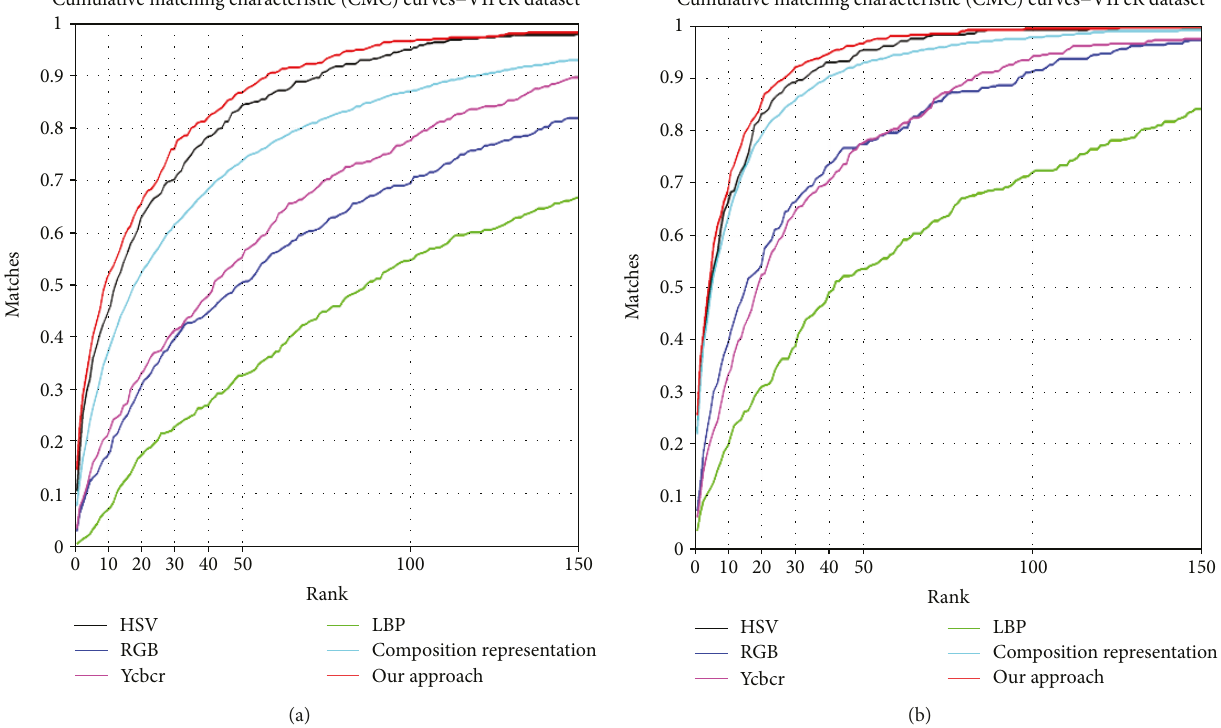
Figure 4: Performance on the VIPeR dataset in terms of CMC curves (top 150 ranking positions). P = 100 samples are selected as the training data in (a). P = 316 samples are selected as the training data in Table 1: Matching rates of di ff erent approaches on the VIP E R dataset.